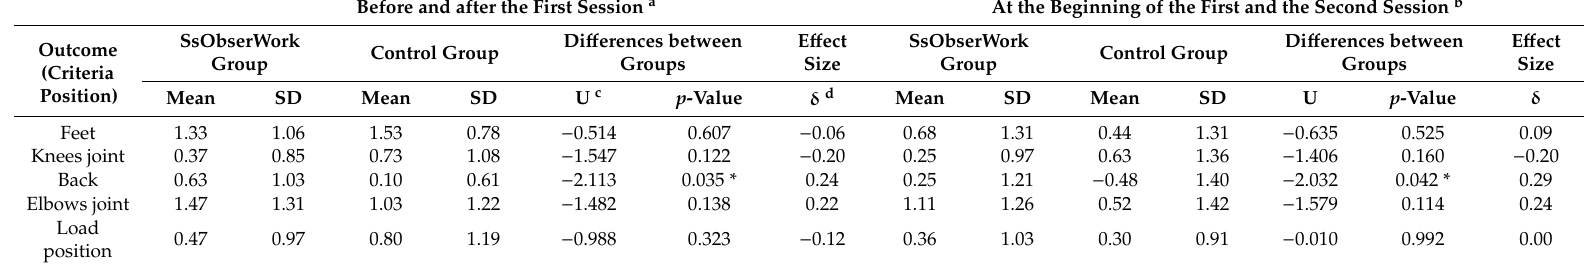
Table 2. Mean and standard deviation of score change of the frequency of recommended positions for criteria identified by the SsObserWork and control group, and di ff erences between them. Before and after the First Session a At the Beginning of the First and the Second Session